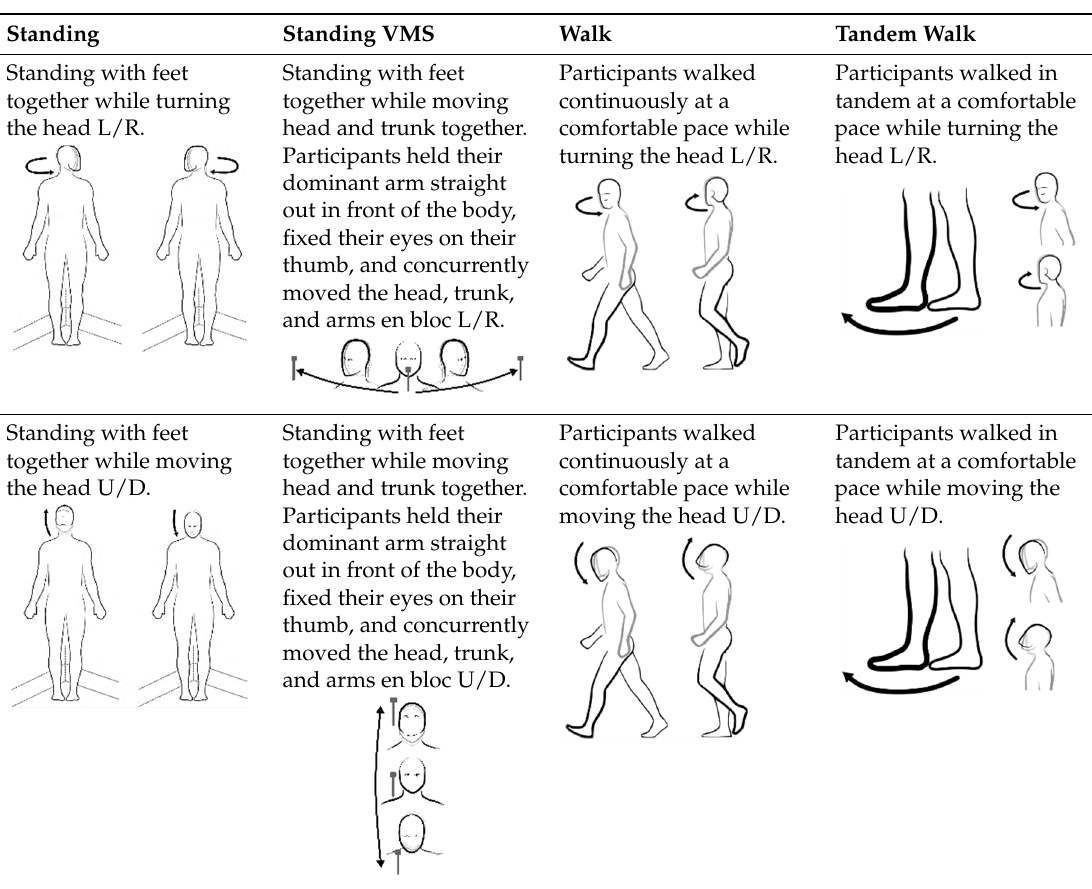
Table 1. Description of standing and walking conditions.